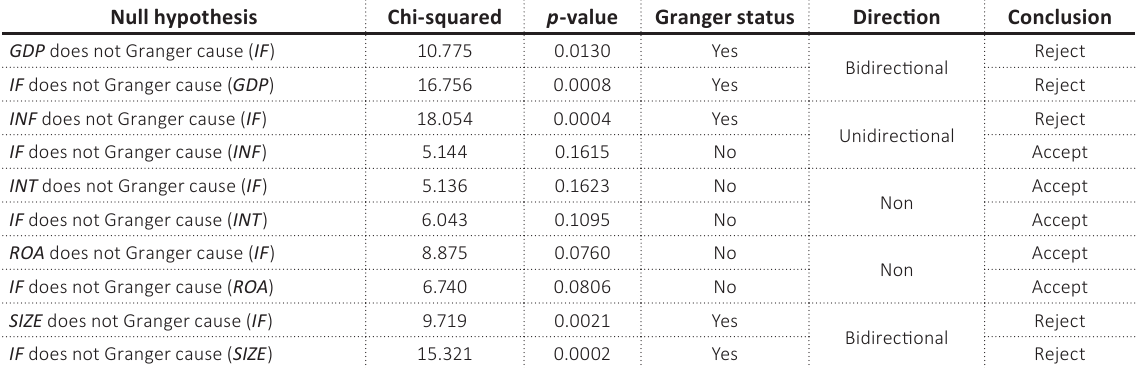
Table 7. The results of block exogeneity Wald test